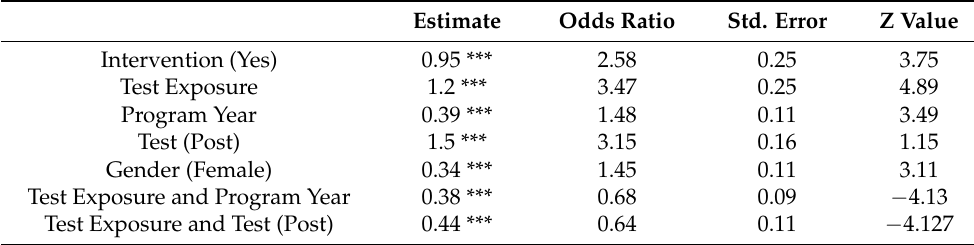
Table 3. Multilevel OLR analysis final